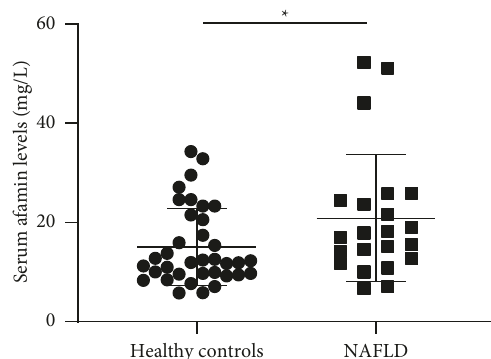
Figure 3: Differentially serum afamin levels in biopsy-proven participants. A total of 58 biopsy-proved participants including 22 biopsy-confirmed NAFLD patients and 36 healthy controls were enrolled. The serum afamin levels were significantly higher in the biopsy-proved NAFLD patients than in the healthy controls ( P < 0 . 01). A significance analysis was conducted using Student’s t - test.